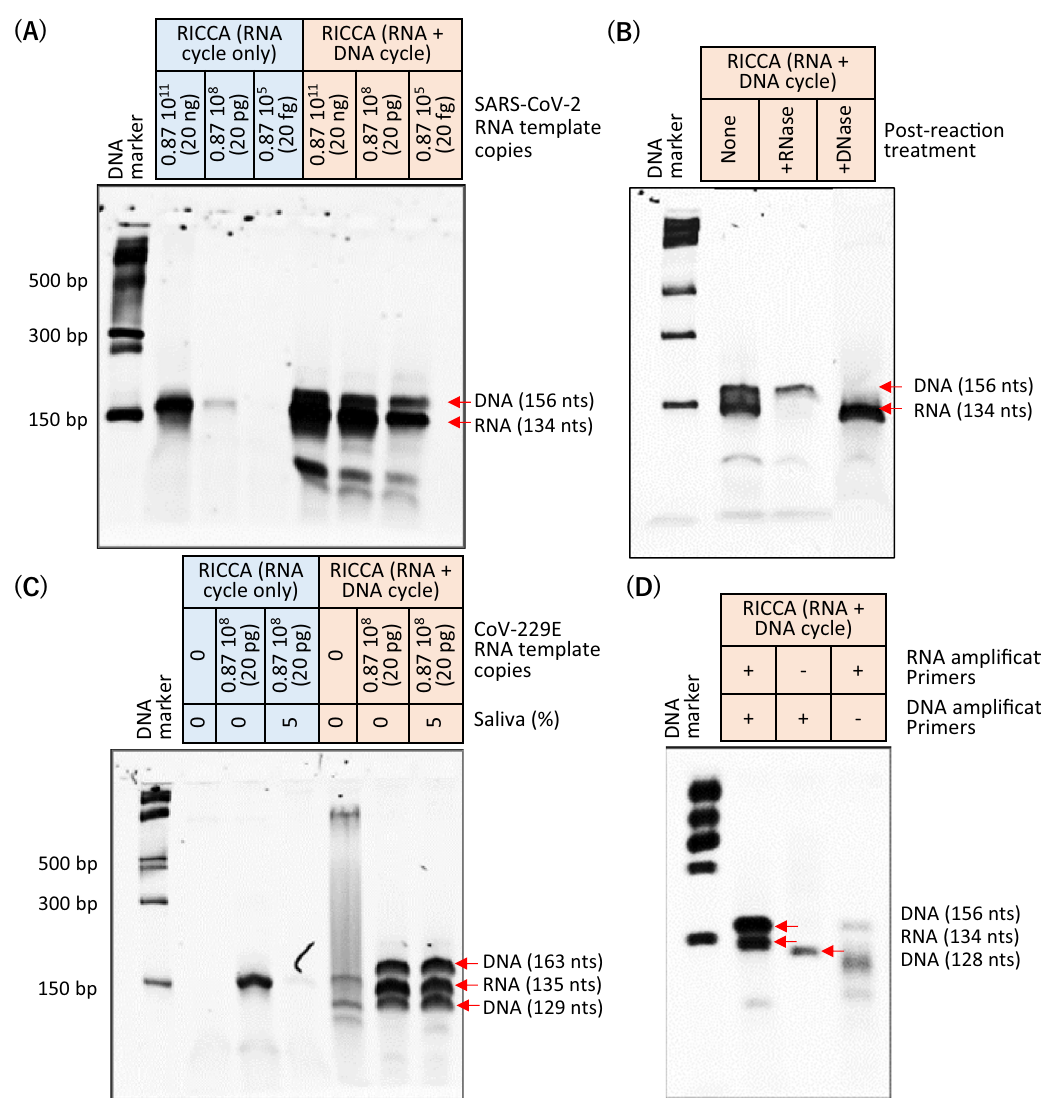
Figure 5. Proof-of-concept demonstration of RICCA. ( A ) Electrophoretic analysis to comparatively evaluate the detection limit of RNA-specific amplification only versus RNA-specific amplification with DNA-specific amplification to amplify low template copy numbers ranging from 20 ng to 20 ag. The desired amplified products (134-nt RNA and 156-bp DNA) are shown by red arrows in the gel electrophoretic analysis. ( B ) RNA- or DNA-specific amplicons were confirmed by treatment with DNase or RNase, respectively. ( C ) Electrophoretic analysis to compare the detection limit of RNA-specific amplification only versus RNA-specific amplification with DNA-specific amplification in the absence or presence of saliva using a freshly synthesized template for CoV-229E RNA. The desired amplified product (135-nt RNA or 163-bp DNA) is indicated by red arrows. ( D ) Electrophoretic analysis to evaluate the co-assisted efficiency of RNA- and/or DNA-specific amplification during the RICCA reaction in the absence and/or presence of primers for RNA and/or DNA-specific